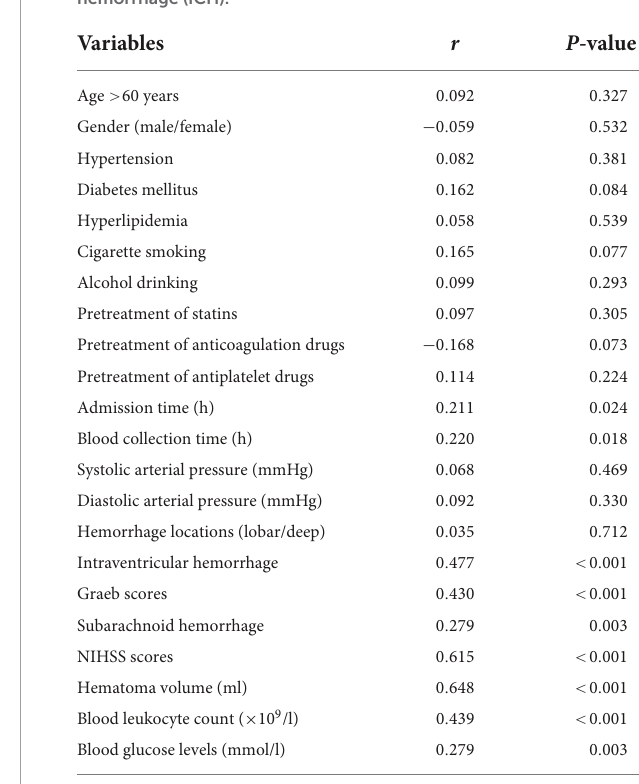
TABLE 2 Factors correlated with serum nuclear factor erythroid 2-related factor 2 (Nrf2) levels after acute intracerebral hemorrhage